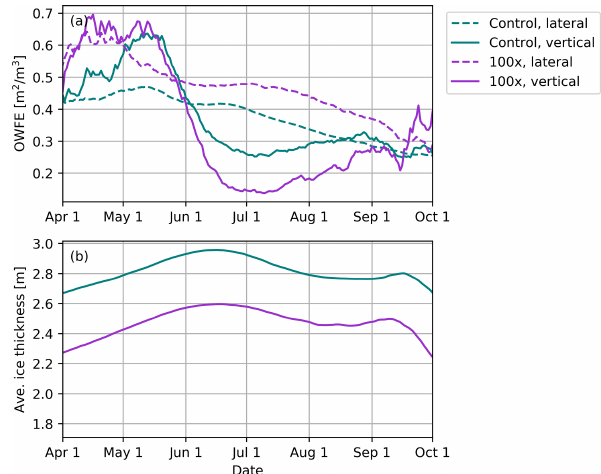
Figure 7. Daily (a) open-water-formation efficiency (OWFE) of lat- eral and vertical melt and (b) average sea ice thickness over the Northern Hemisphere over the melt season. Results are shown for control and 100 × lateral melt runs only (teal and purple, respec- tively) and are averages over the last 25 run